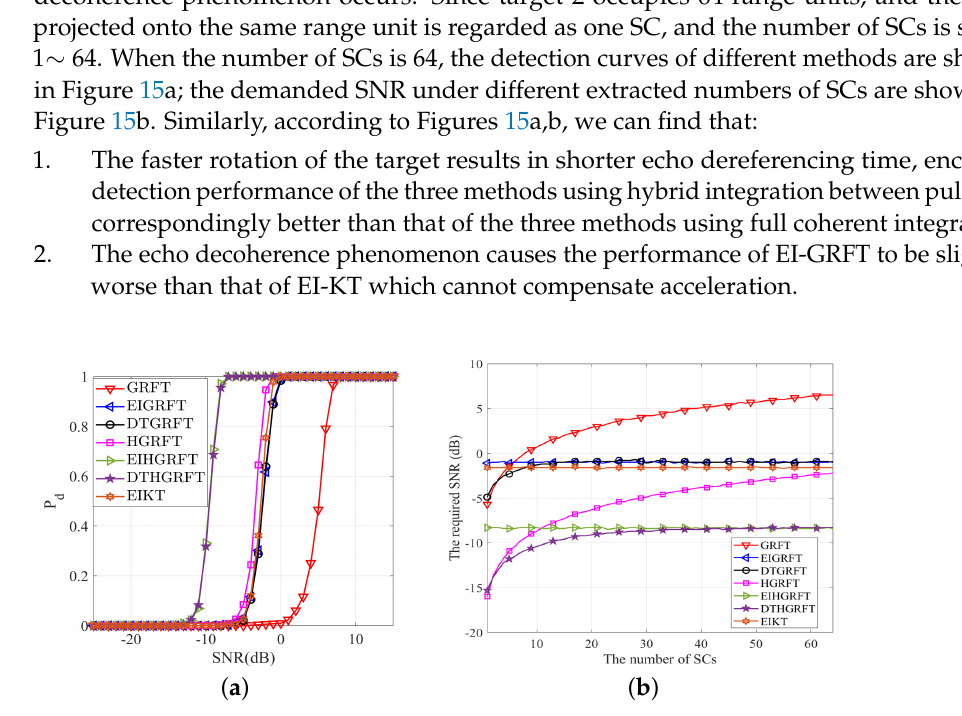
Figure 15. The comparison results of detection performances of different methods for target 2. ( a ) The curve of P d at L = 64. ( b ) The curve of demanded